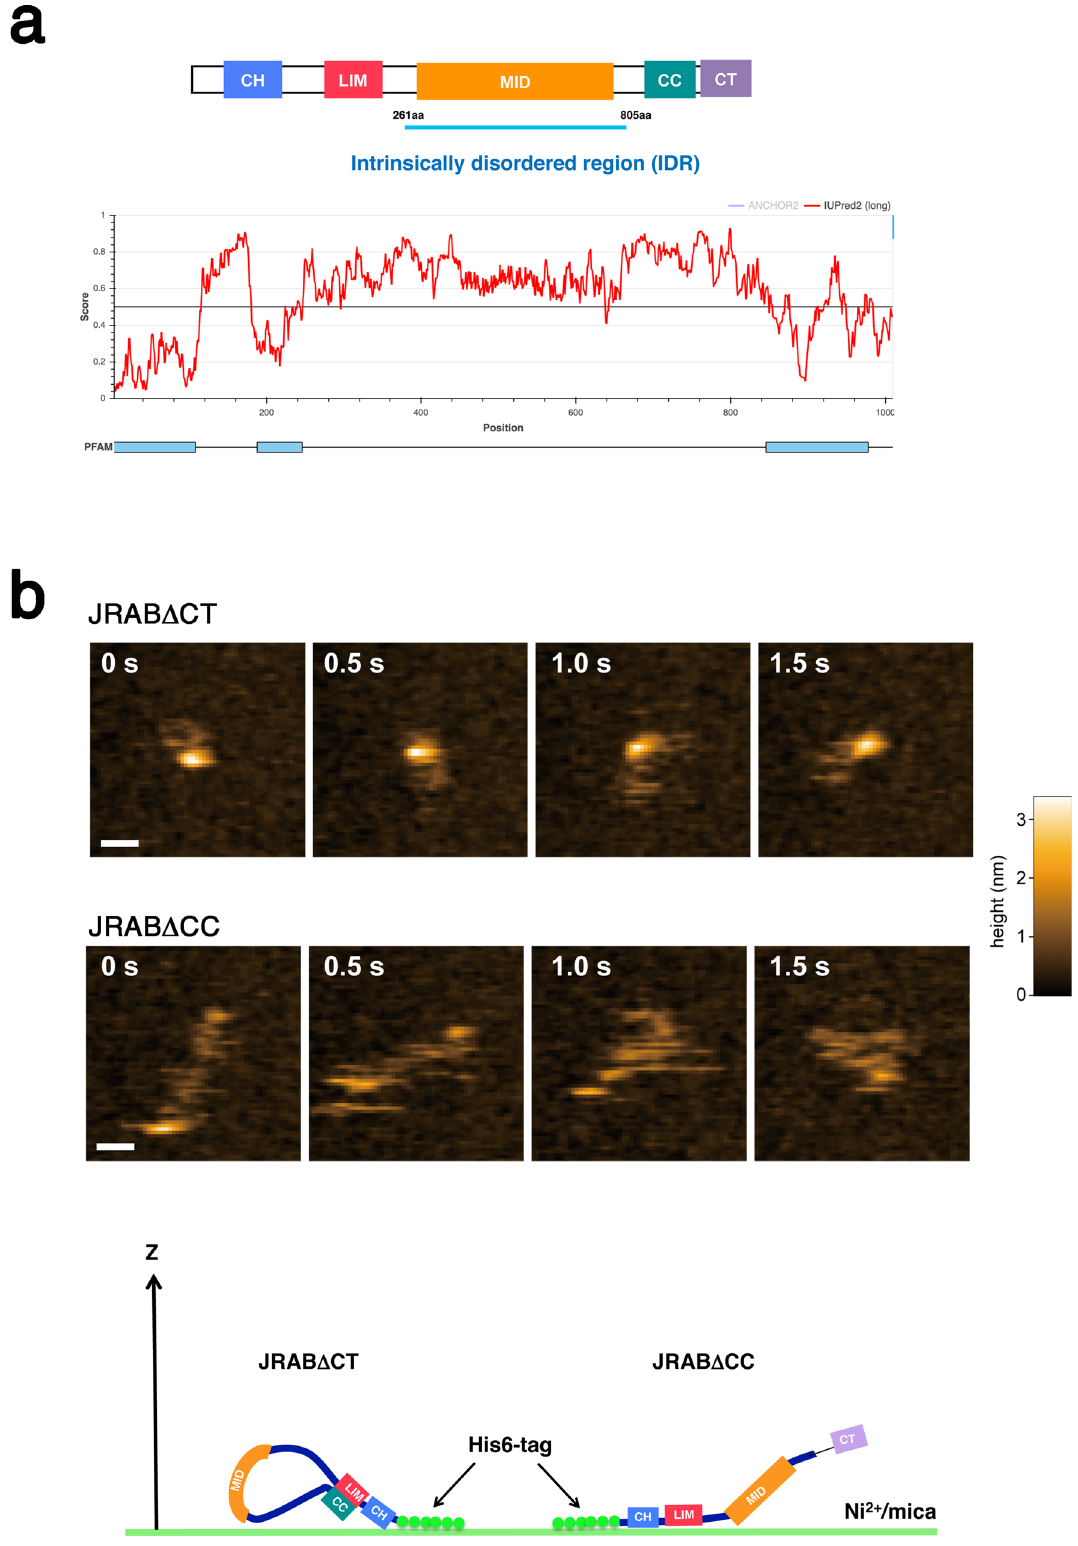
All plasmids constructed in this study were sequenced using an ABI Prism 3100 genetic analyzer (Applied Biosystems). Cell culture . HeLa cells were cultured in Dulbecco ’ s modi fi ed Eagle ’ s medium (DMEM) with 10% fetal bovine serum (FBS), 100 U/ml penicillin, and 100 μ